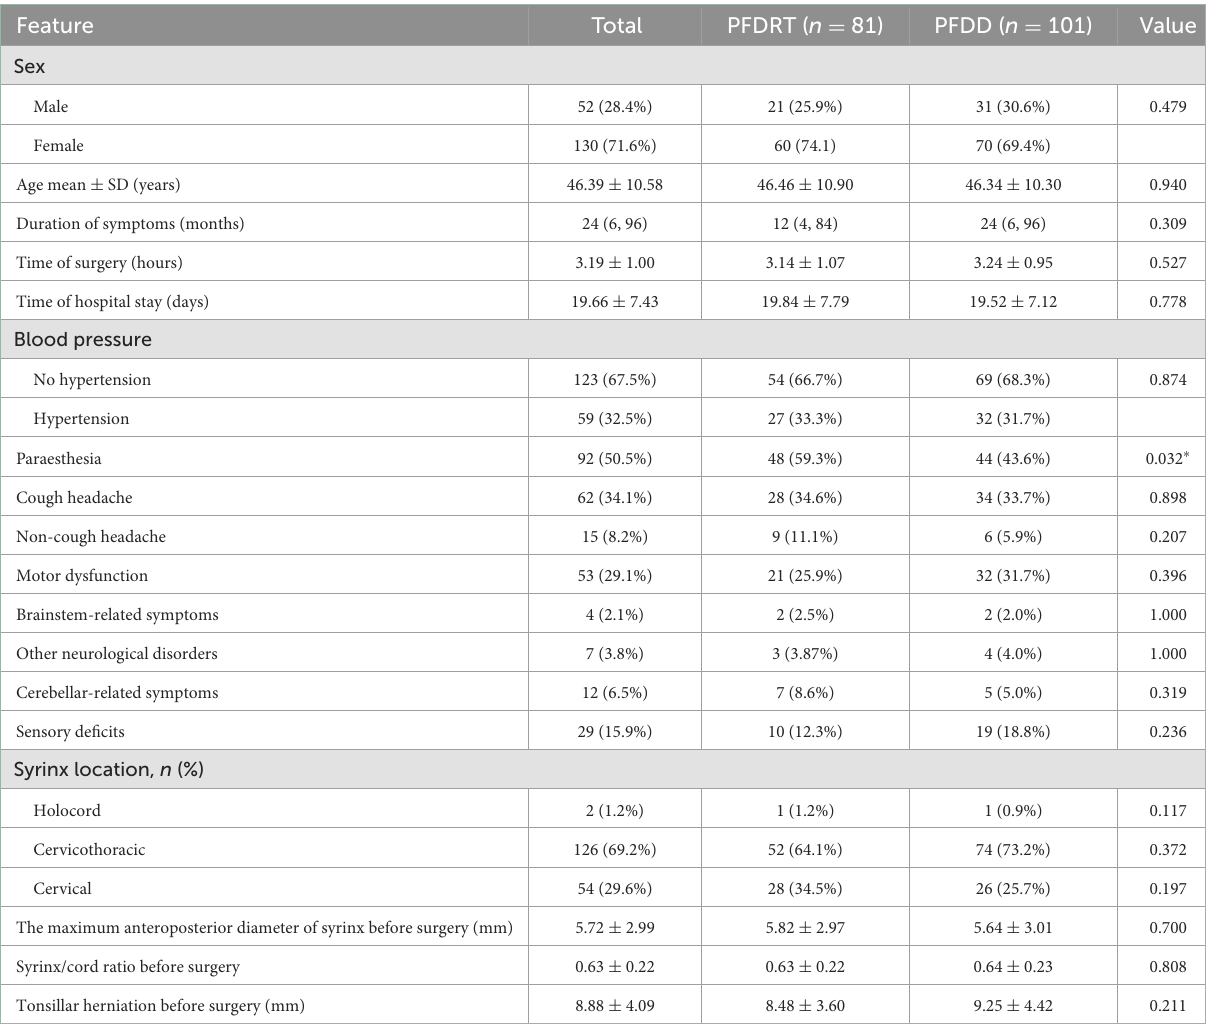
TABLE 1 Demographic and clinicoradiological characteristics before